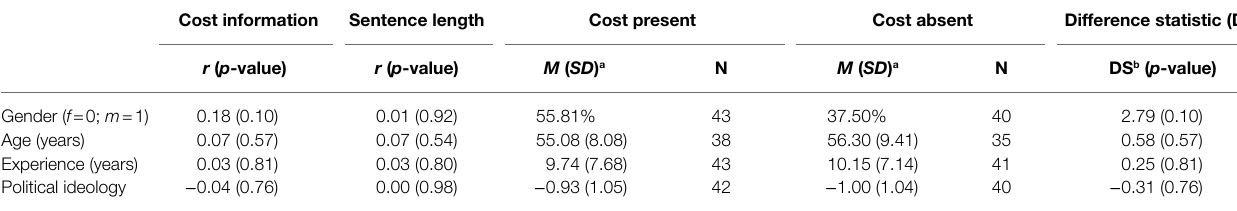
TABLE 1 | Relations of demographic variables to independent variable (cost information) and dependent variable (sentence length). Cost